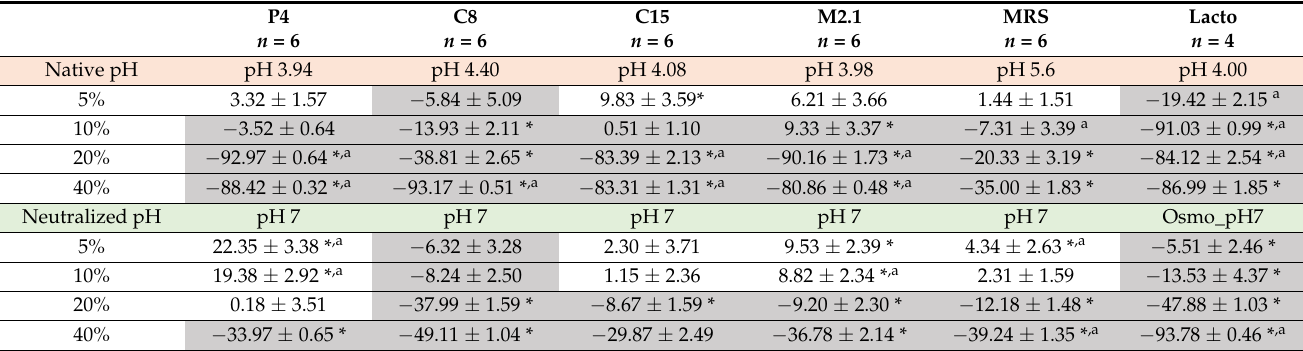
Table 1. Hydrogen ion concentration (pH) of MRS after 24 h incubation period of lactobacilli, its neutralization up to pH = 7, and the mean OD (at 570 nm) values estimated by MTT test, representing inhibition/proliferation rate in % of non-confluent HT29 treated for 24 h with different SN concentra- tions from four strains (P4, C8, C15 and M2.1) of Lacticaseibacillus paracasei and the controls, Lacto and Osmo. P4 C8 C15 M2.1 MRS Lacto n = 6 n = 6 n = 6 n = 6 n = 6 n = 4 pH 4.40 pH 4.08 pH 3.98 pH 5.6 pH